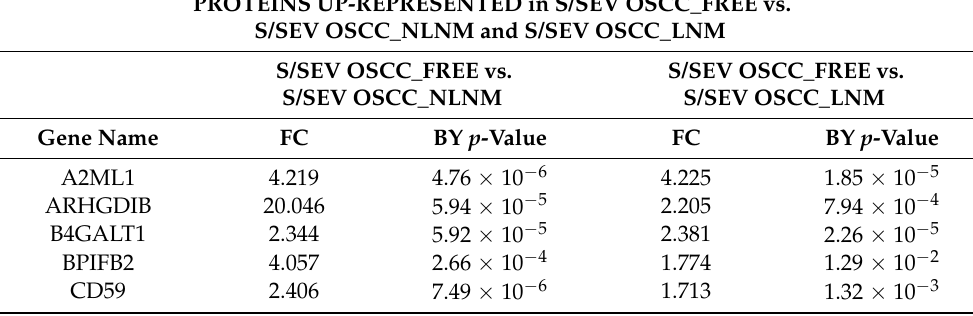
Table 5. Proteins specifically up-represented in S/SEV OSCC_FREE. PROTEINS UP-REPRESENTED in S/SEV OSCC_FREE